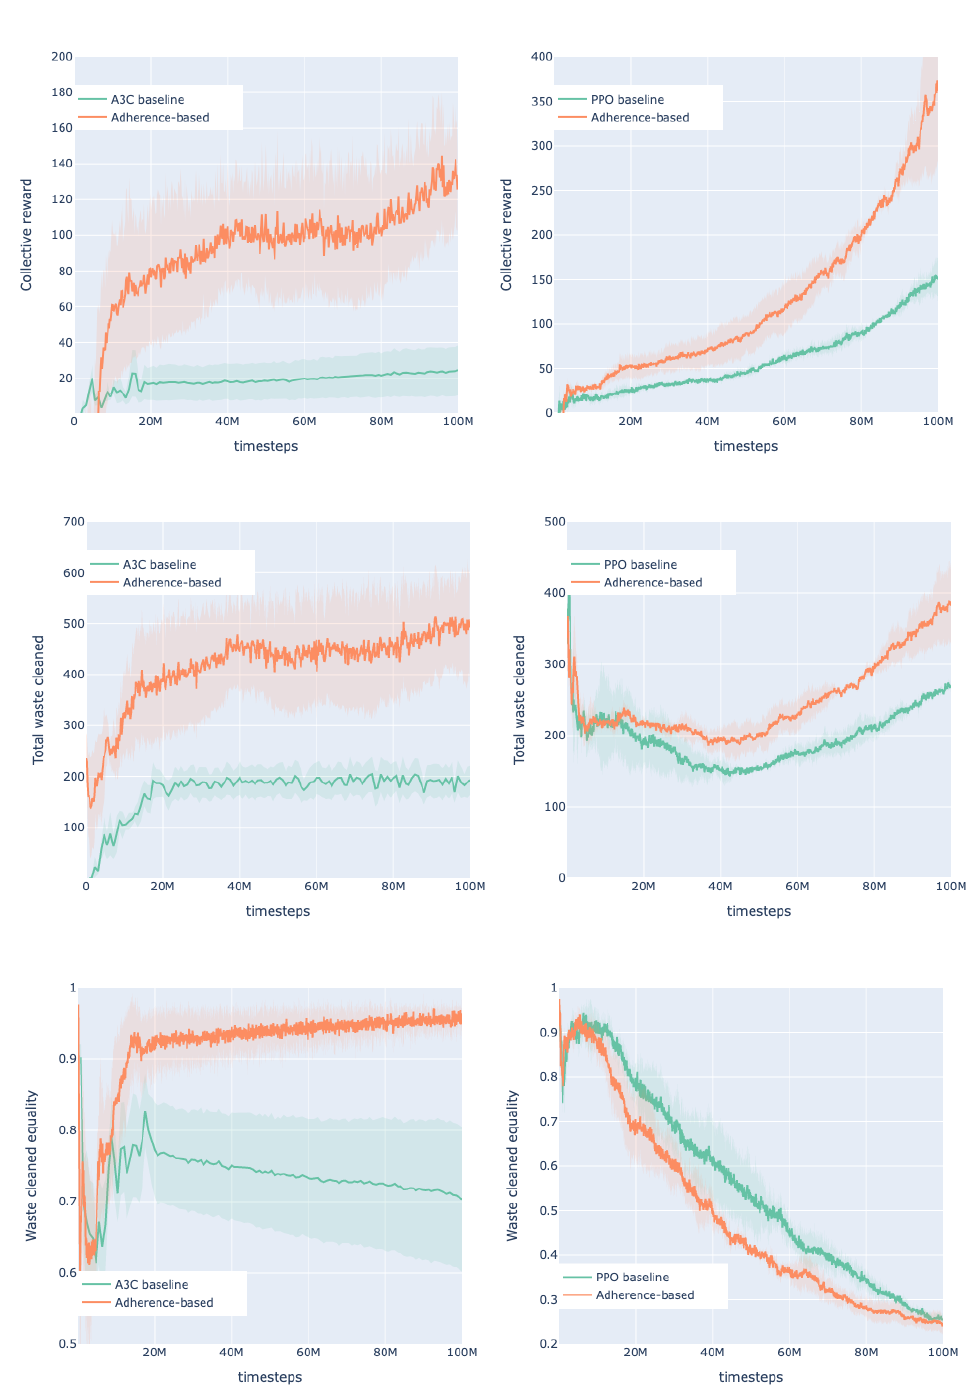
Figure 3. The effect of the adherence-based algorithm on social outcomes in Cleanup. The social outcome metrics are collective reward, total waste cleaned and equality of the waste cleaned, respec- tively. The left three figures are the results of our method applied to A3C. The right three figures are the experiment results based on